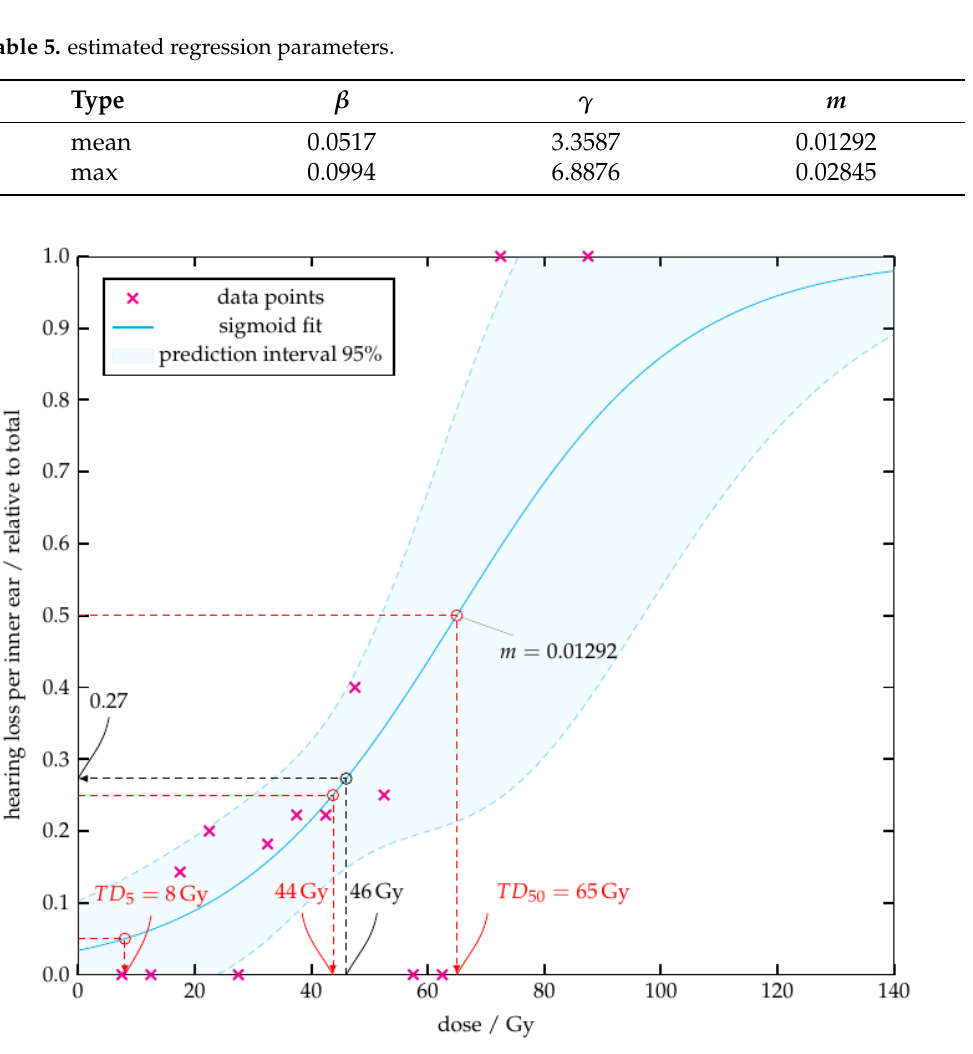
Figure 4. Inner ear side effects depending on mean radiation dose. The curve describes the incidence of inner ear side effects depending on the dose administered to the inner